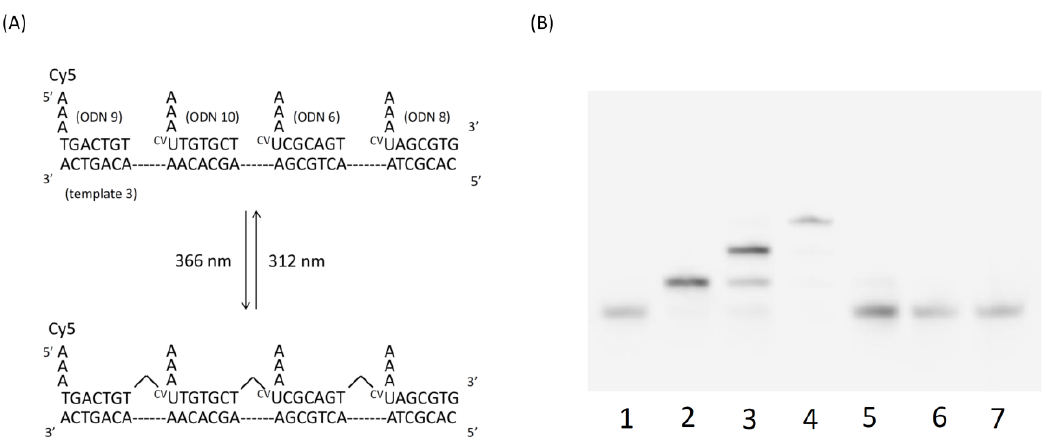
Figure 5. ( A ) Schematic illustration of reversible photoligation with CV U and Cy5; ( B ) Cy5 fluorescence of a Denaturing PAGE of the photoreaction of ODN 9, 10, 6, 8 and template 3 was annealed and photoirradiated at 366 nm for 900 s at 4 °C and 312 nm for 1,800 s at room temperature. Lane 1, ODN 9 + template 3 + 366 nm; Lane 2, Lane 1 + ODN 10; Lane 3, Lane 2 + ODN 6; Lane 4, Lane 3 + ODN 8; Lane 5 Lane 4 + 312 nm; Lane 6, Lane 4 without template 2; Lane 7, Lane 4 without irradiation at 366